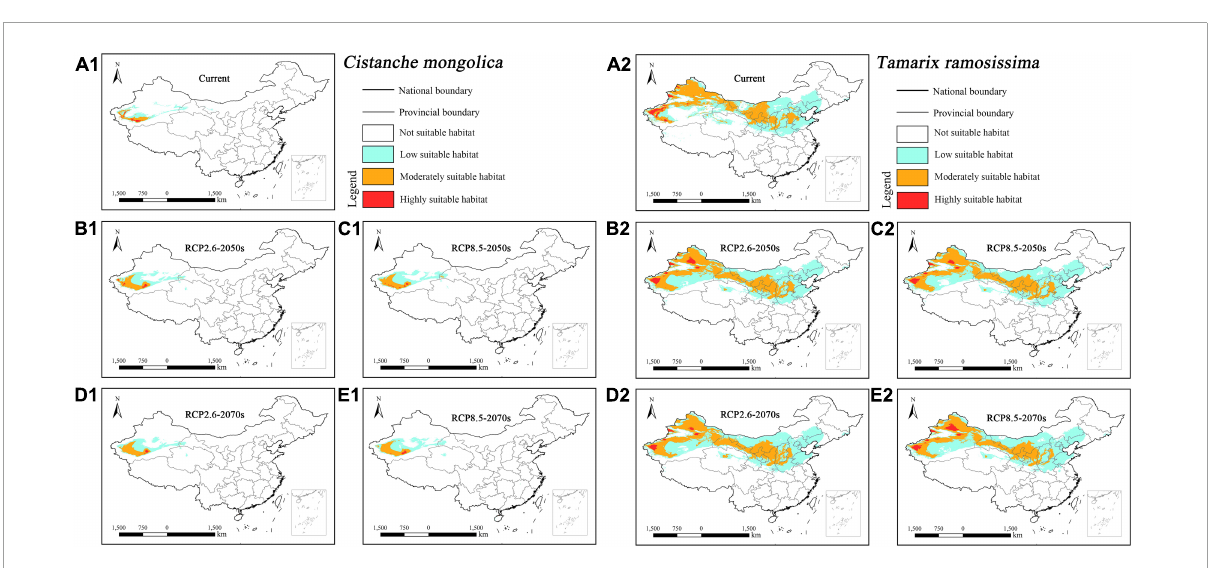
FIGURE6 Predicted suitable habitat distributions of Cistanche mongolica (A1–E1) and its host Tamarix ramosissima (A2–E2) under different climate scenarios in China.